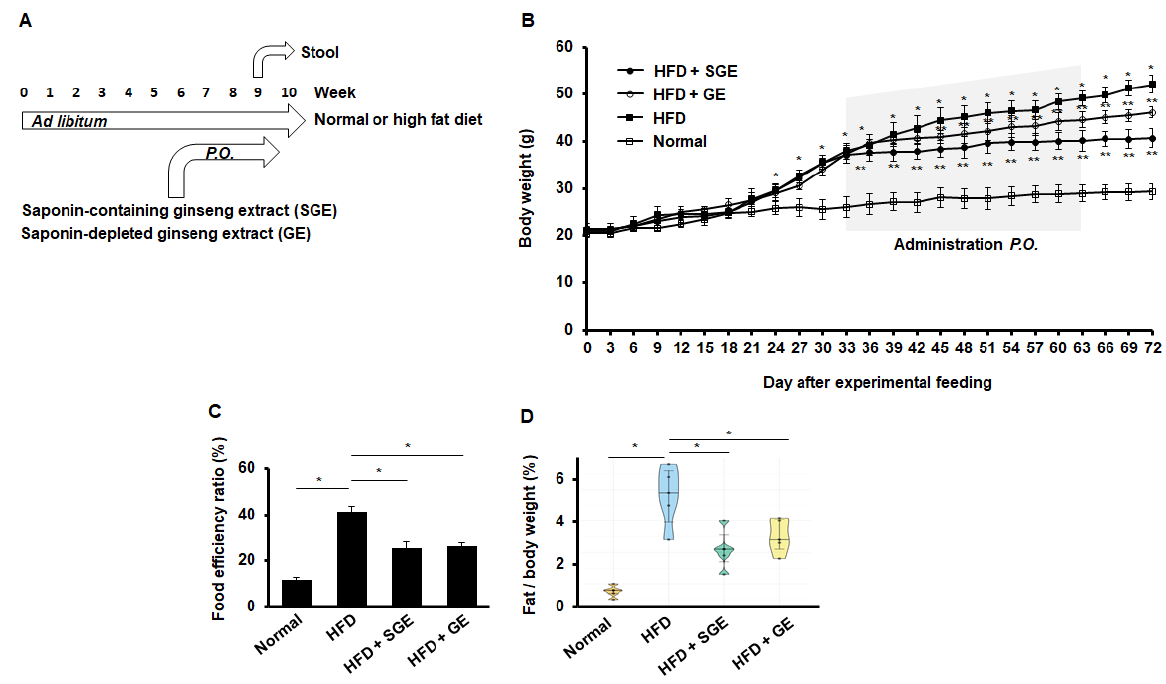
Figure 1. Korean red ginseng inhibits HFD-induced mouse obesity. ( A ) Experimental course. Mice ( n = 15/group) were fed ad libitum with normal or high-fat diet for 70 days. Ginseng extract (SGE) or depleting saponins (GE) were per os added two times a week for one month. Stool samples were gathered for further research. ( B ) Body weights. Asterisks indicate statistical significances (*, p < 0.05; **, p < 0.01). A grey box indicates the administration times. Normal and HFD indicate normal and high-fat diet, respectively. ( C ) Food efficiency ratio ( n = 15/group). *, p < 0.05. ( D ) A ratio of fat/body weight ( n = 5/group). *, p <